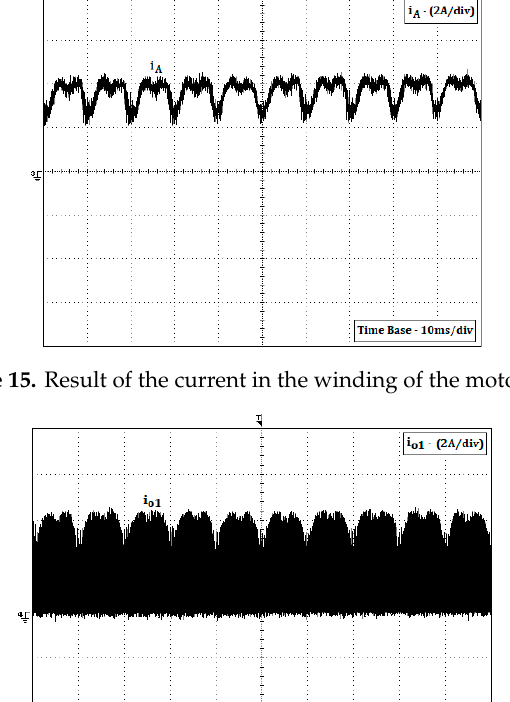
Figure 15. Result of the current in the winding of the motor (i A ).